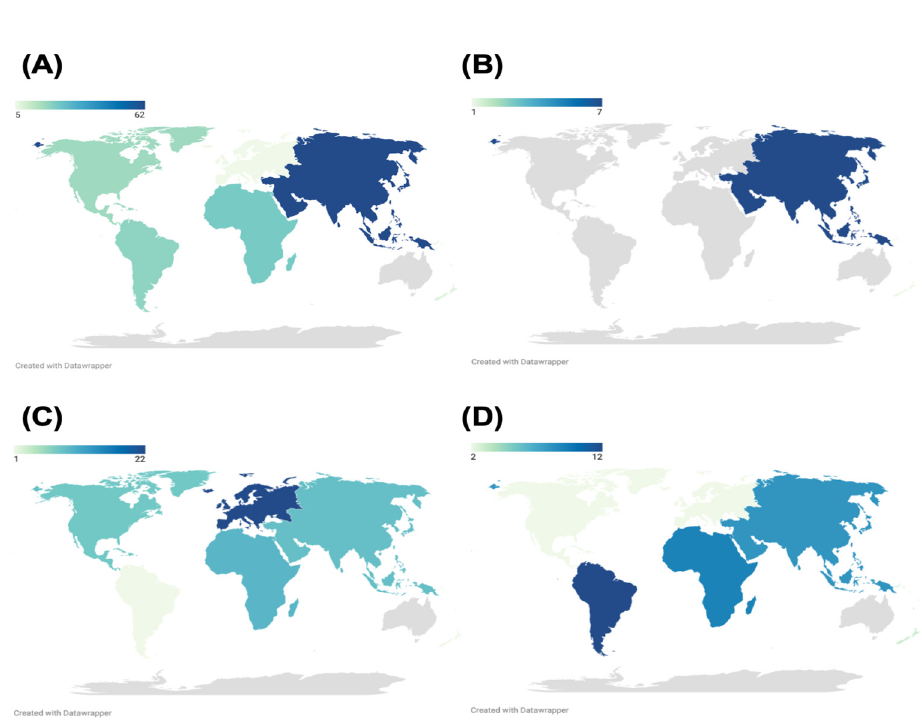
Figure 2. Distribution of flavivirus seroprevalence studies by region: ( A ) DENV, ( B ) JEV, ( C ) WNV, ( D ) ZIKV.